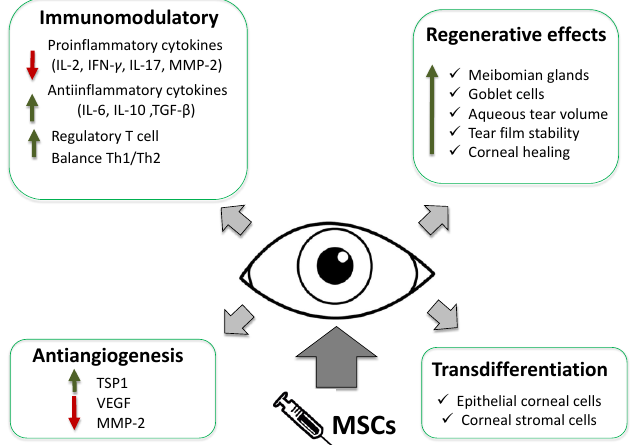
Figure 2. Main mechanisms of action of MSCs implantation in dry eye and ocular surface. IFN-γ: interferon-gamma; IL-2: interleukin 2; MM-2: matrix metalloproteinase-2.